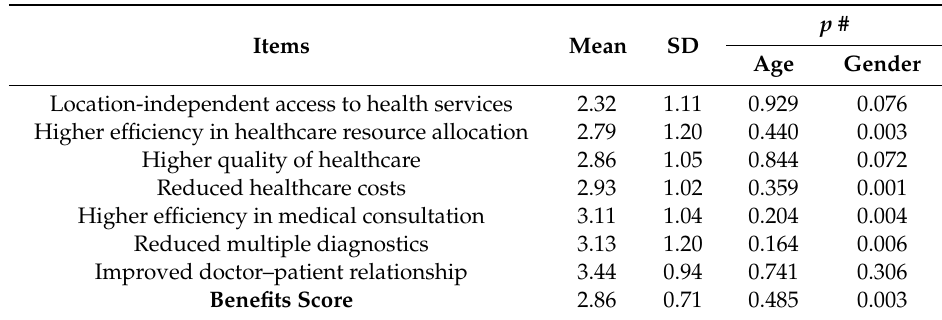
Table 1. Benefits of health apps ( n = 90).